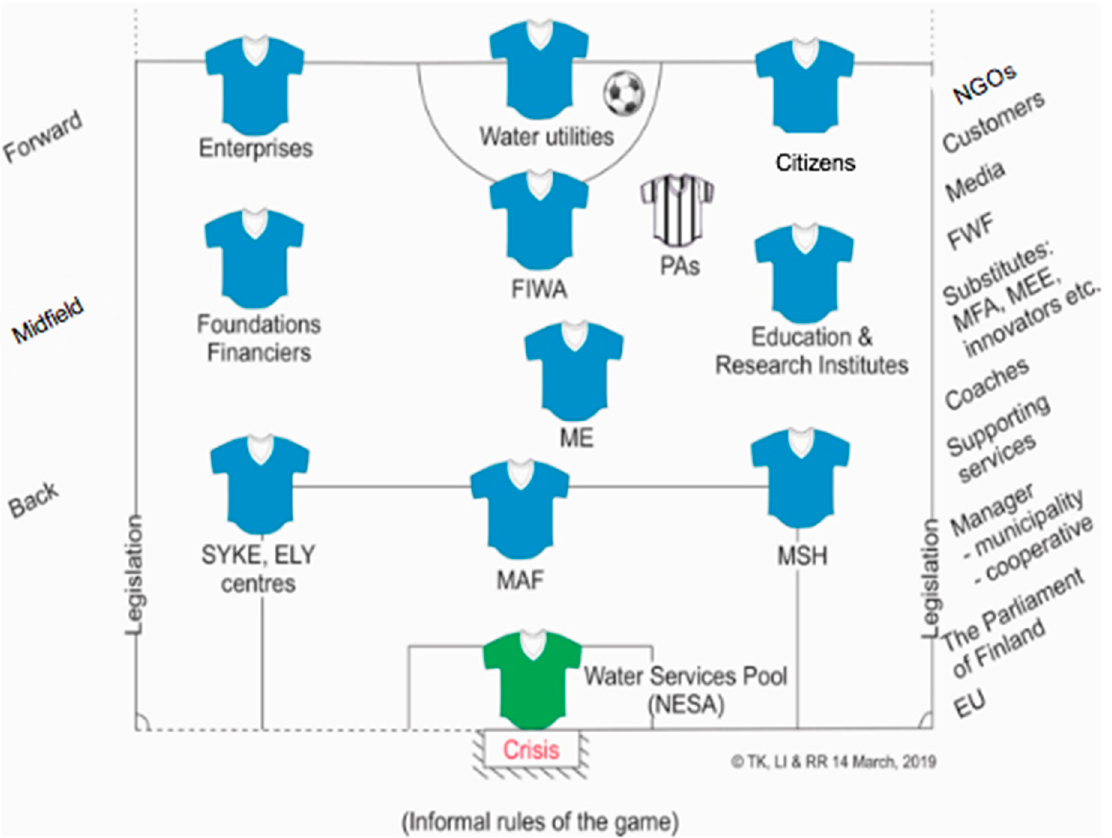
Figure 1. Finnish “water soccer”: Finnish utility-based water services against Team Chaos. Acronyms and abbreviations on the field: FIWA = Finnish Water Utilities Association; PAs = permit authorities; ME = Ministry of Environment; SYKE = Finnish Environment Institute; ELY = Centre for Economic Development, Transport and the Environment; MAF = Ministry of Agriculture and Forestry; MSH = Ministry of Social Affairs and Health; NESA = National Emergency Supply Agency. In the supporting team: NGOs = non-governmental organizations; FWF = Finnish Water Forum; MFA = Ministry of Foreign Affairs; MEE = Ministry of Employment and the Economy.